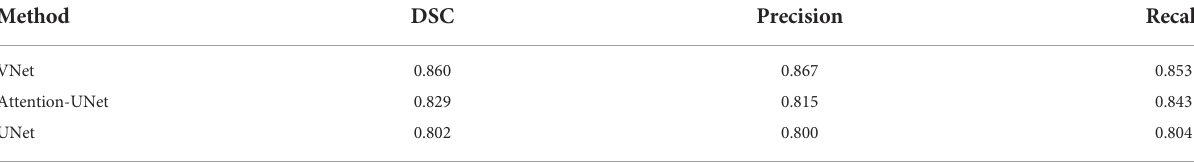
TABLE 2 The results of the segmentation models.